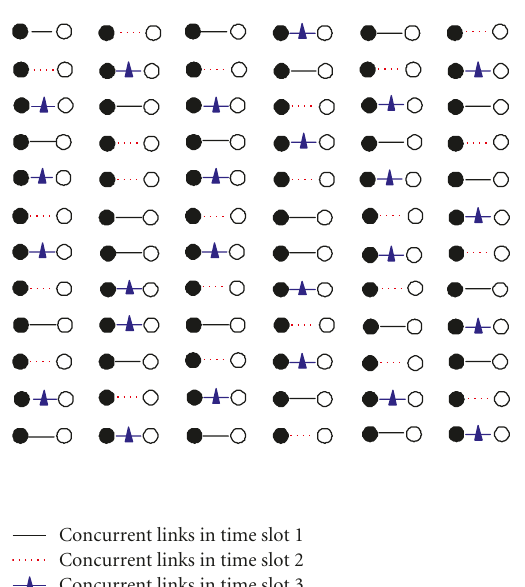
Figure 4: A square network of 72 links with links partitioned, by the DCLS algorithm with K = 3, into three subsets corresponding to three time slots, where black circles represent transmitting nodes and blank circles denote receiving nodes.